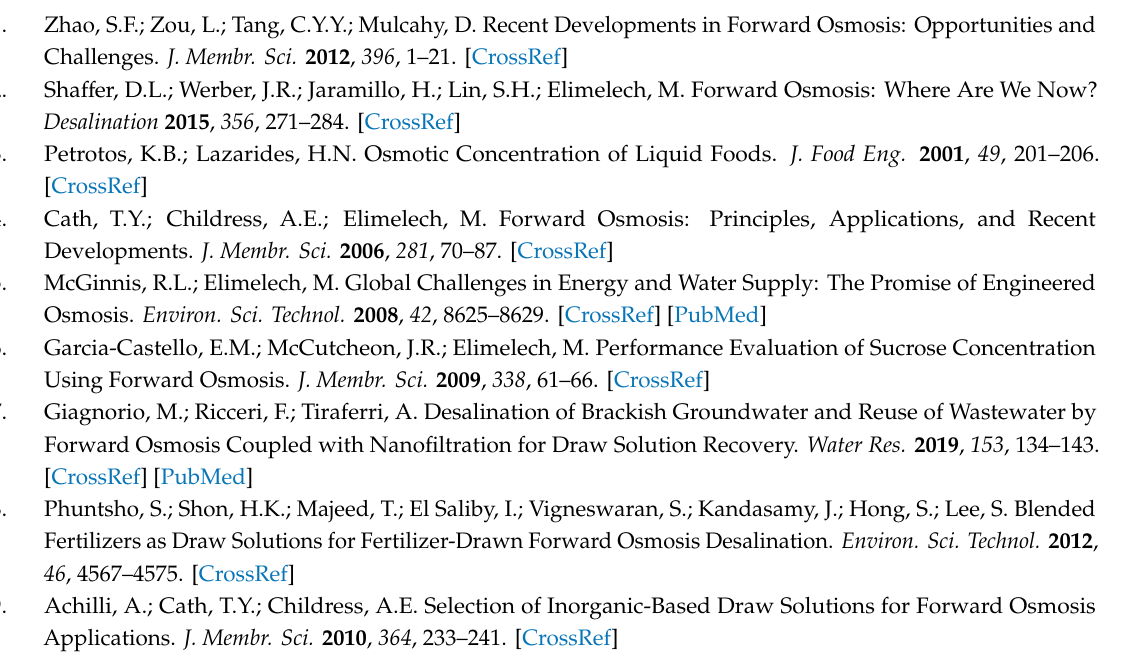
Figure S1: Preliminary simulations performed to select the forward osmosis operational parameters, Figure S2: Results of the fouling experiments performed with calcium chloride as draw solution, at an initial osmotic pressure of 18.4 bar, Table S1: Transport properties of the forward osmosis membrane, Table S2: Characteristics of the nanofiltration membranes selected for the draw solution regeneration